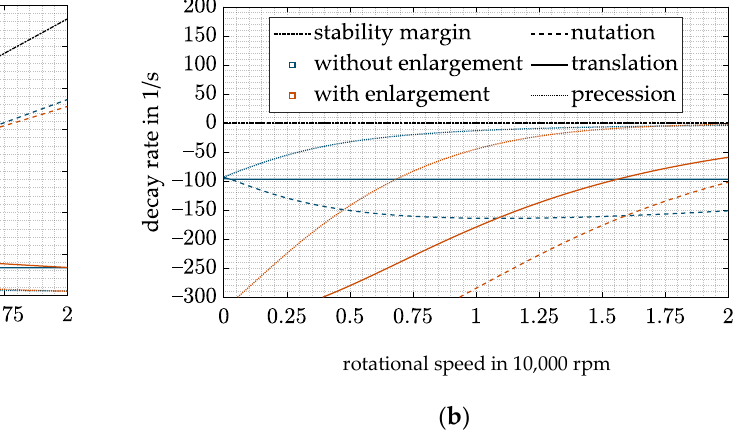
Figure 7. ( a ) Campbell diagram with DFC; ( b ) decay rate with DFC.